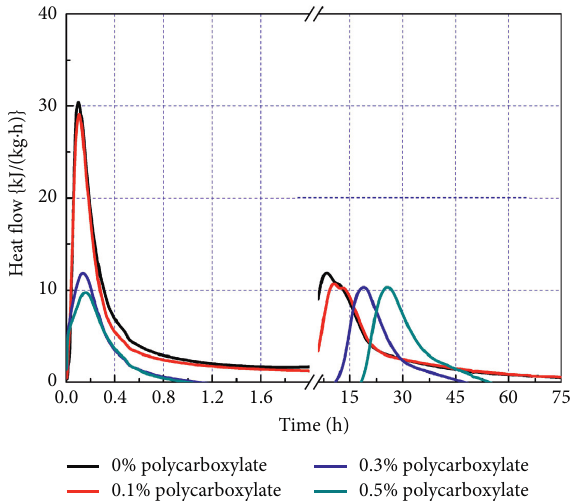
Figure 9: Effect of PCE-2 dosage on hydration heat flow of cement pastes with 10%